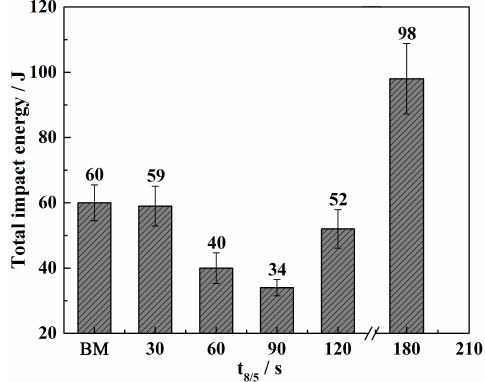
Figure 7: Vickers hardness of the BM and the simulated CGHAZ versus t 8/5 (The error bars represent standard deviation).